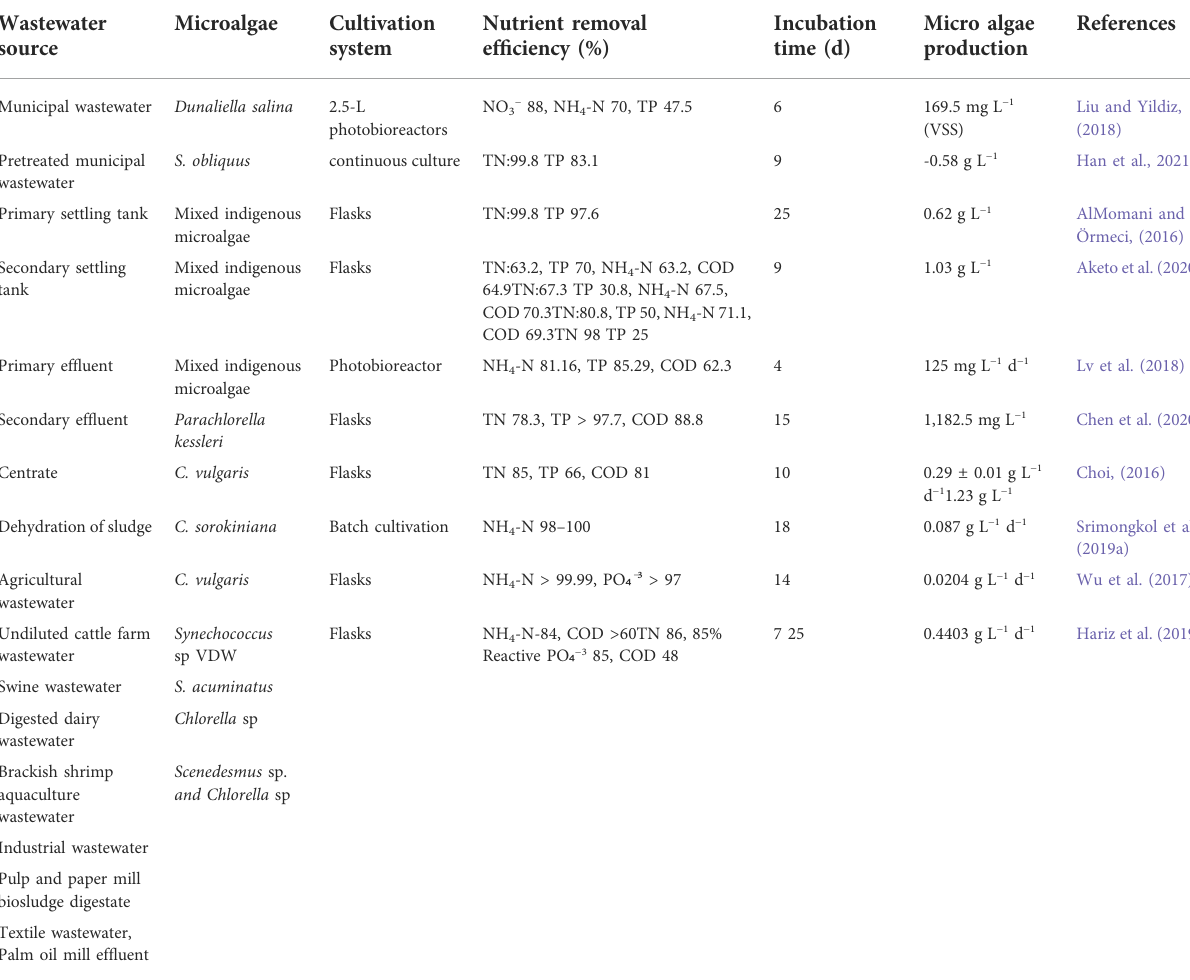
TABLE 3 Role of microalgae in different types of wastewaters in terms of nutrient removal ef fi ciency, incubation time, and microalgae production. Wastewater